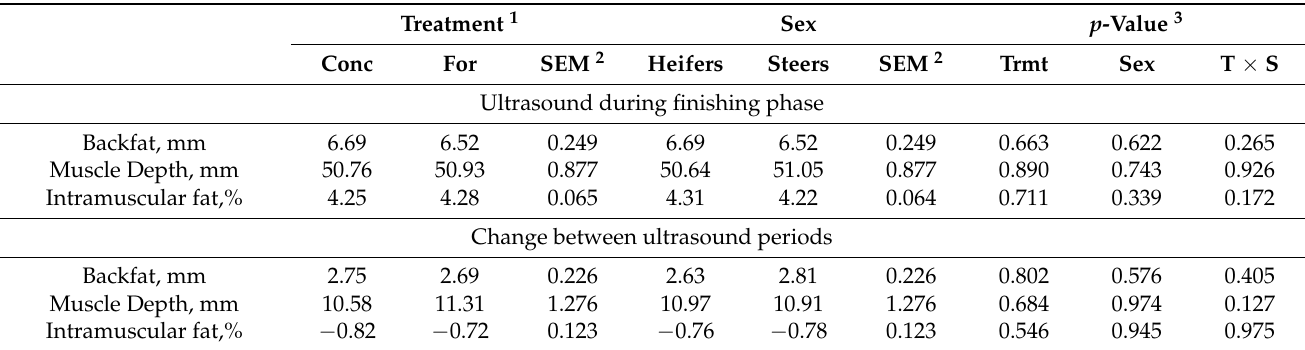
Table 4. Least square means for ultrasound measurements of progeny from dams fed a prepartum dietary carbohydrate source consisting of concentrate-based (Conc) or forage-based (For) diet during mid- and late-gestation. Treatment 1